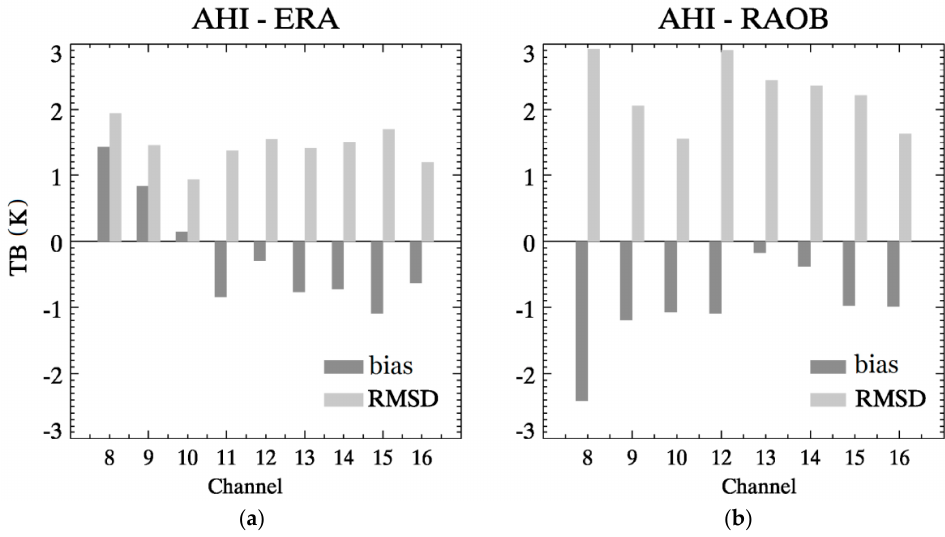
Figure 2 Figure 2. Mean TB bias and root mean square difference (RMSD) between AHI and ( a ) simulated ERA TB over the ocean for 1–10 June 2016; ( b ) simulated RAOB TB over the land for one-month data from June 2016 under clear sky